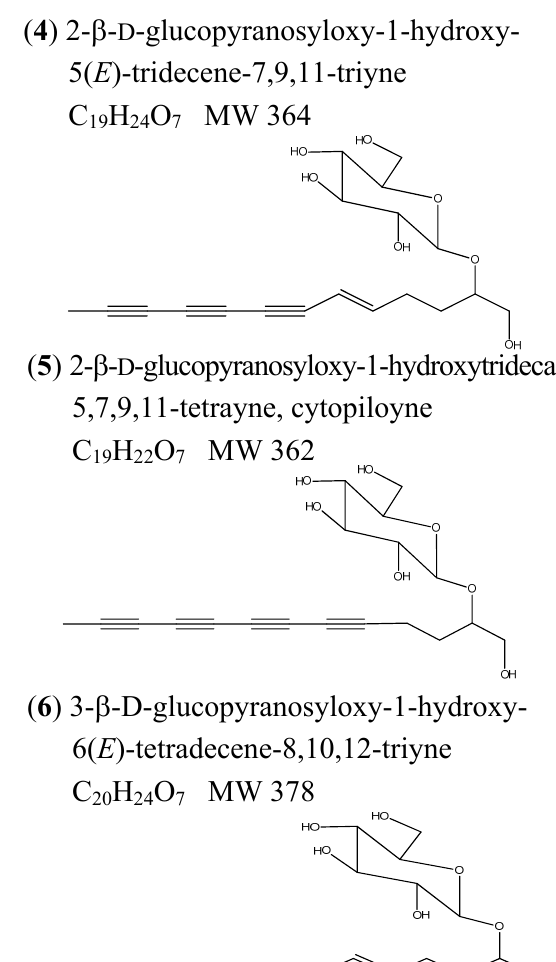
Figure 2. The six chemical structures identified from Bidens pilosa L. var. radiata flower